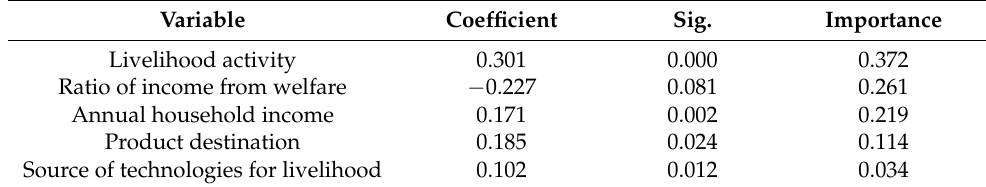
Table 3. Model parameters to predict impacts on material well-being.